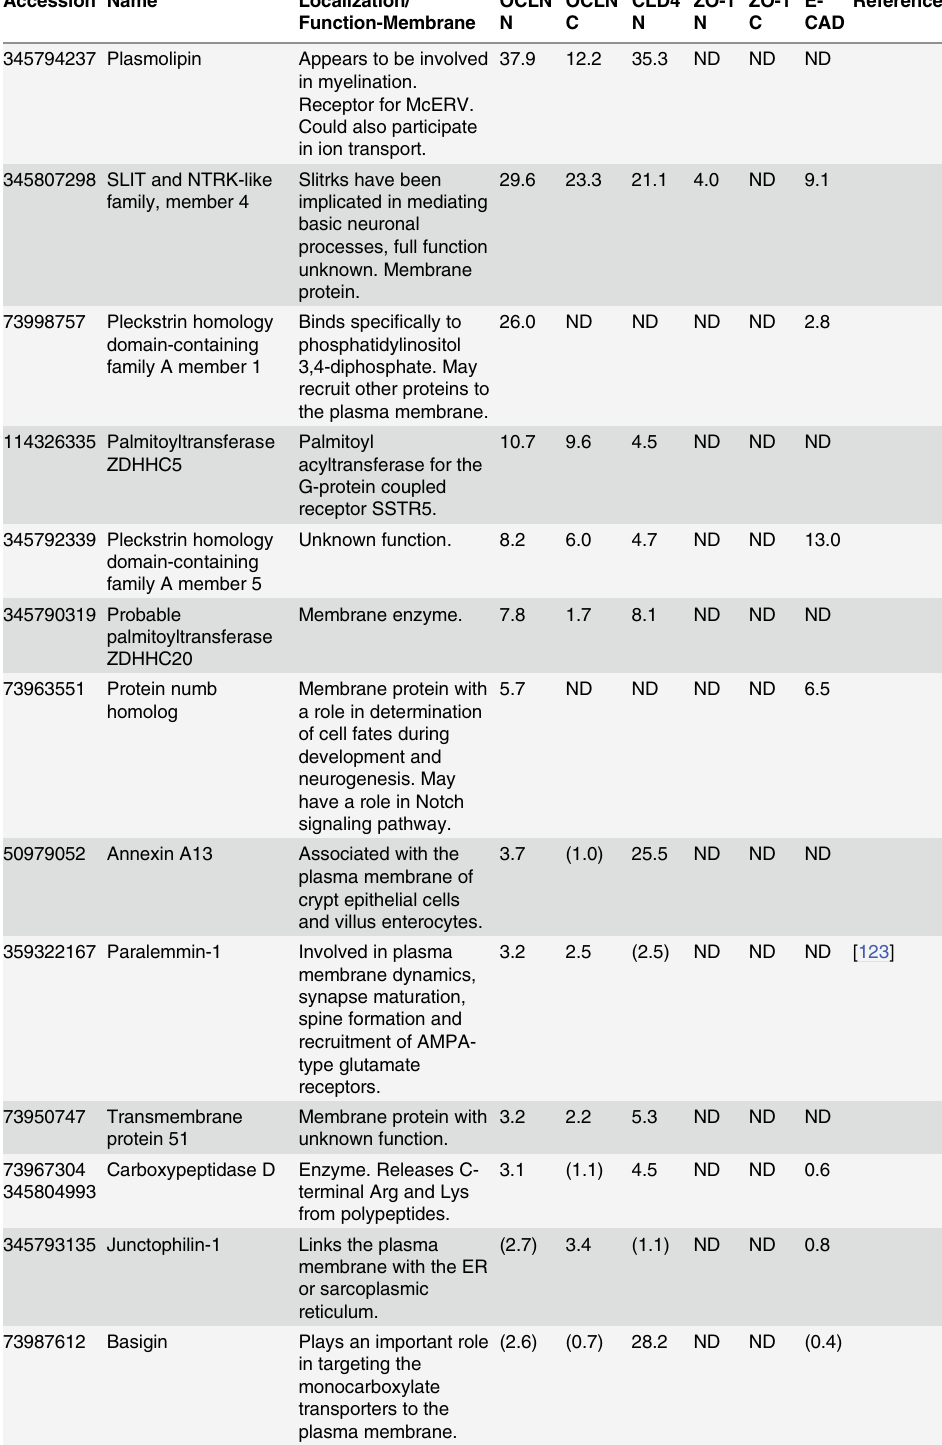
Table 8. Enriched membrane proteins tagged by biotin ligase fused to occludin and